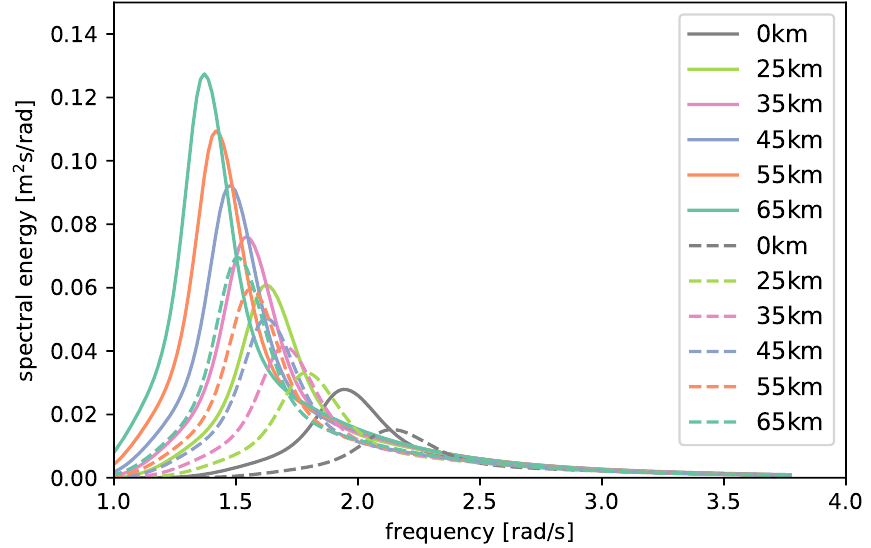
Figure 1. JONSWAP spectra for different distances to the wind farm and wind speeds of 4ms − 1 (solid lines) and 3ms − 1 (dashed lines). At 80km, fetch wave heights of about 0.8m for 4ms − 1 and 0.6m for 3ms − 1 are found. The JONSWAP shape parameters were chosen as γ = 3.3, σ a = 0.07, and σ b =